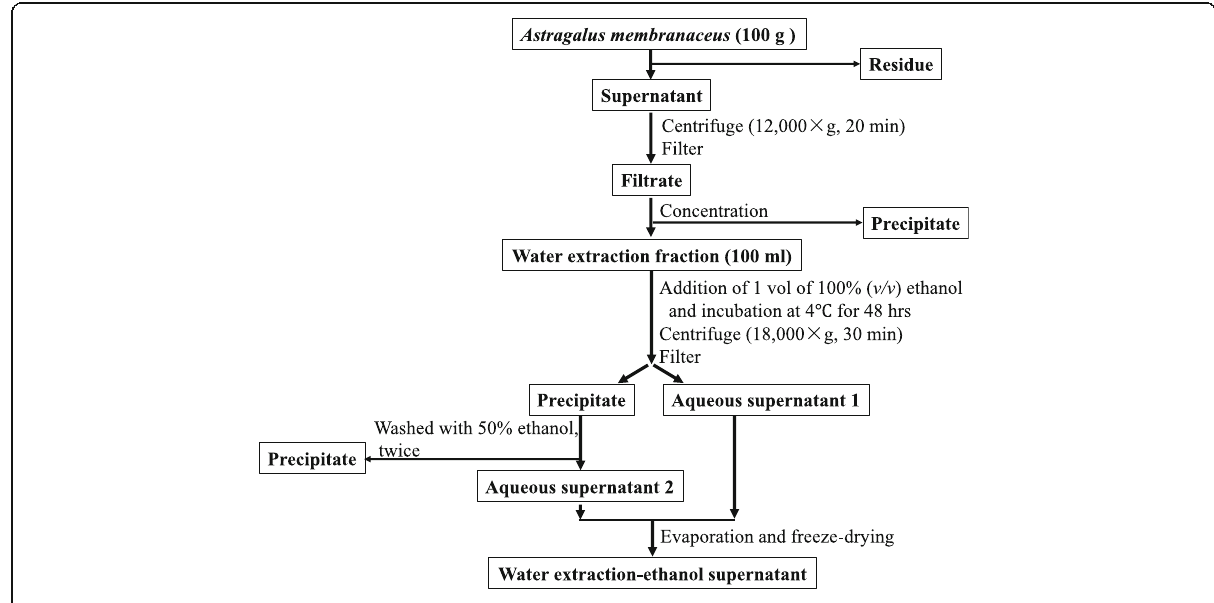
Fig. 1 Schematic depiction of extraction method from